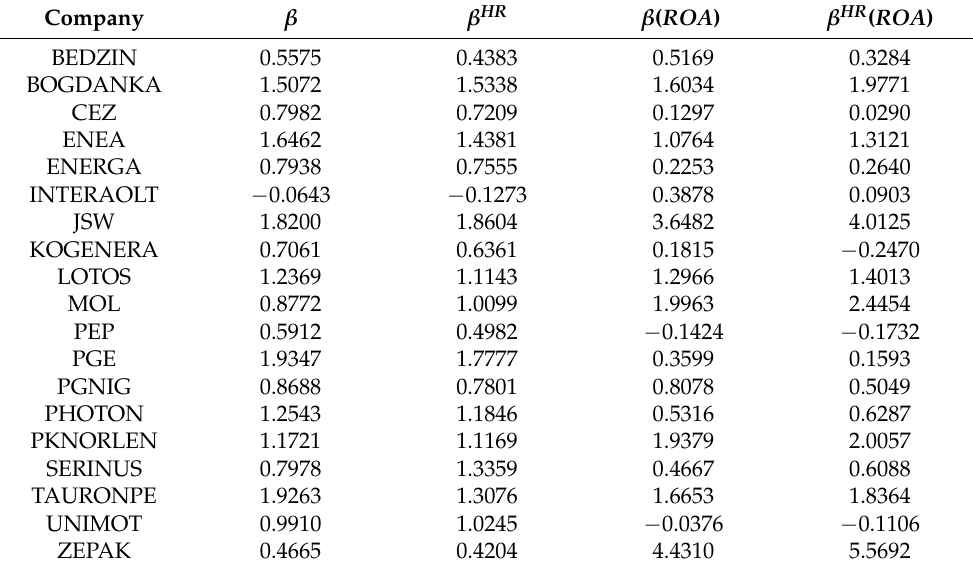
Table 6. Market and accounting beta coefficients for energy companies.